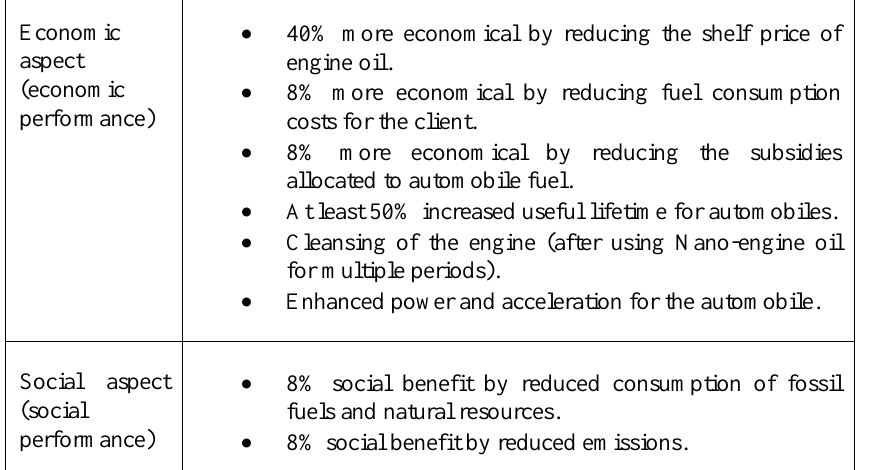
Table 2: The qualitative results of producing Nano-engine oil compared to regular (reference) engine